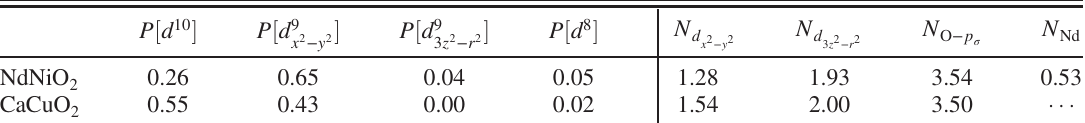
TABLE I. Left-hand portion: Occurrence probabilities P [config] of transition metal d configurations ( e manifold). Right-hand portion: Occupancies N over